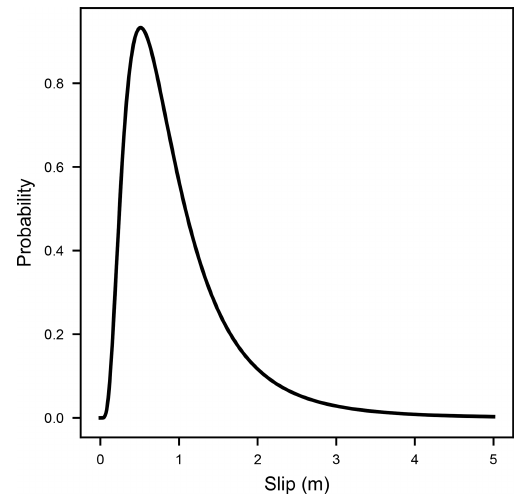
Figure 3. Earthquake slip